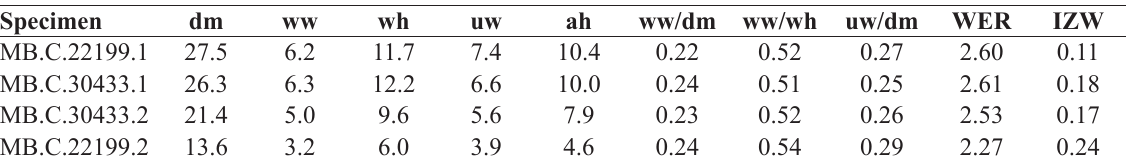
Table 8. Conch dimensions and ratios of selected specimens of Acanthoclymenia forcipifera (Sandberger & Sandberger,